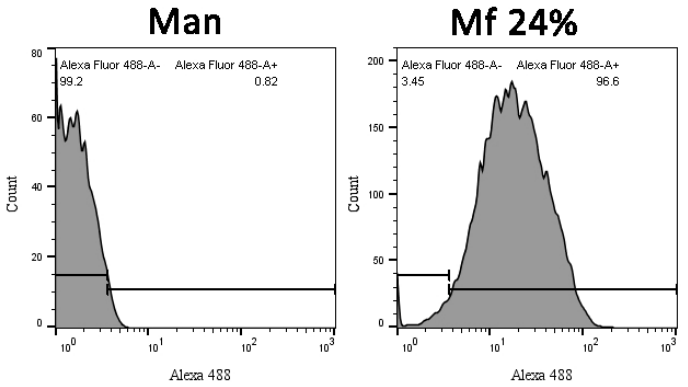
Figure 13. Cytograms of Mannan and Mf 24% bonded beads according to their fluorescence intensity.